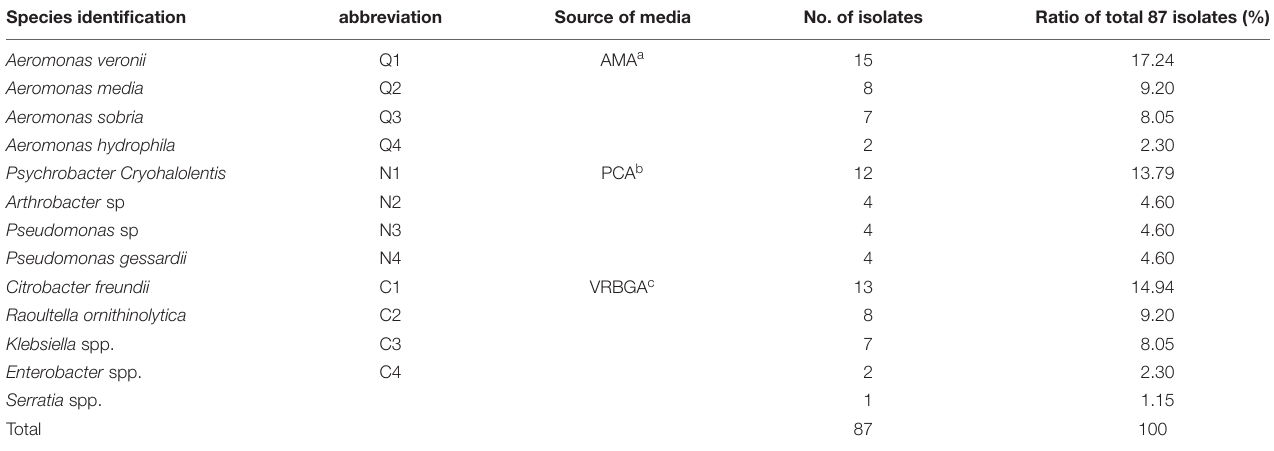
TABLE 1 | The bacteria isolated from vacuum packaged sturgeon stored at 4 ◦